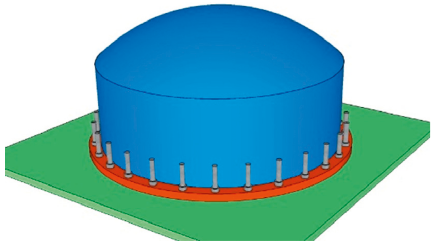
Figure 1: Design model of curved shell structure.